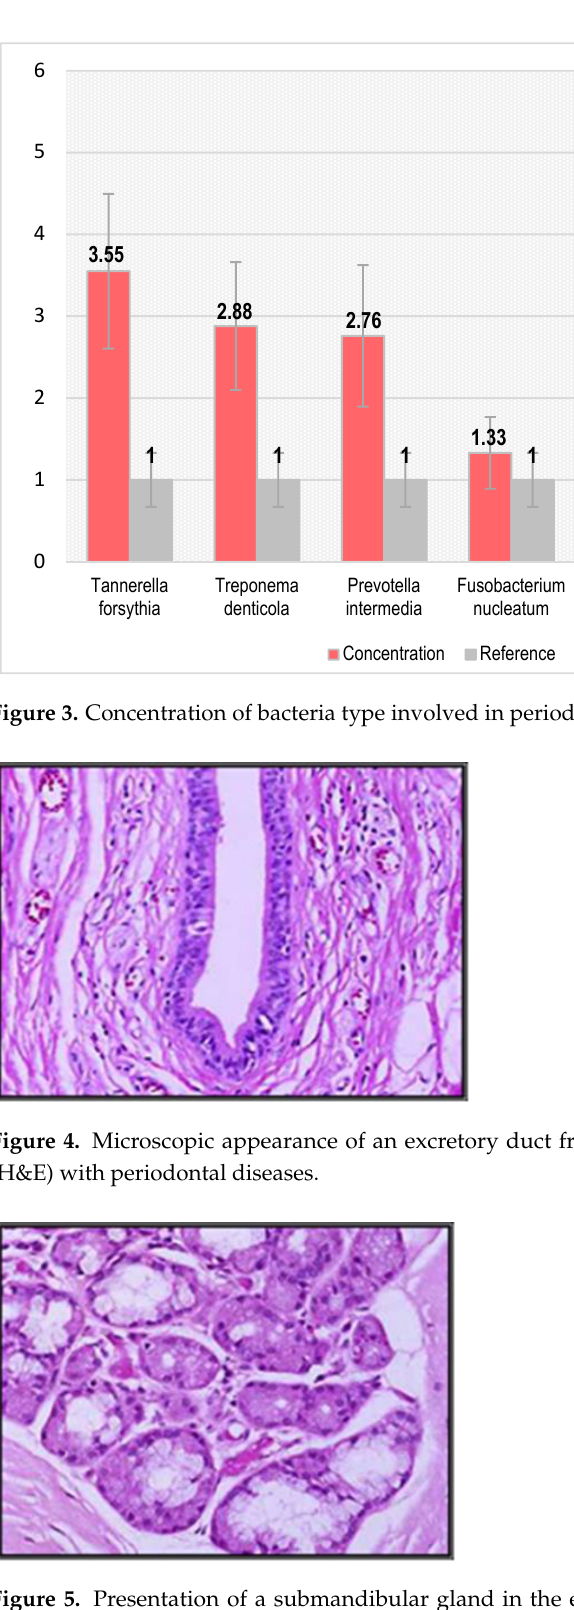
Figure 5. Presentation of a submandibular gland in the elderly with marked berries, inequality dimensionally reduced serous berries, with periodontal disease.